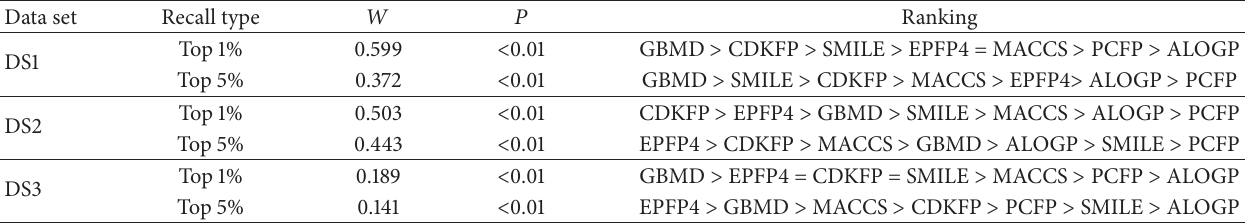
Table 10: Rankings of various types of descriptors based on Kendall 𝑊 test results: Top 1 and 5%.